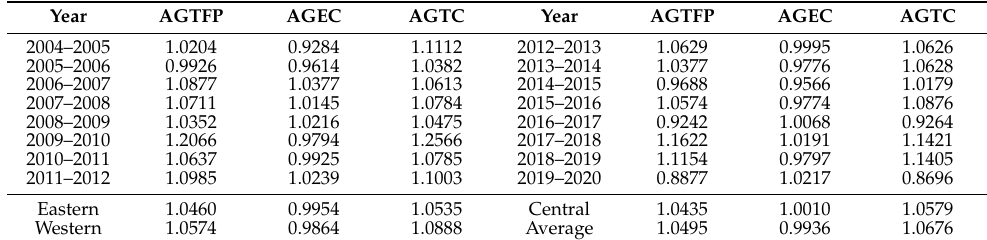
Table 3. China’s AGTFP and its decomposition from 2005 to